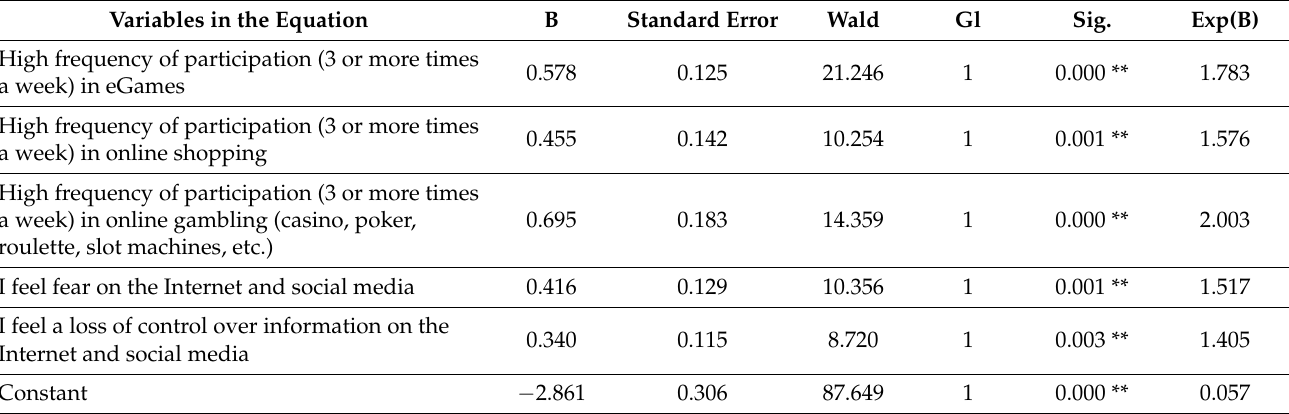
Table 3. Logistic regression model on the probability of perceiving risk or danger in